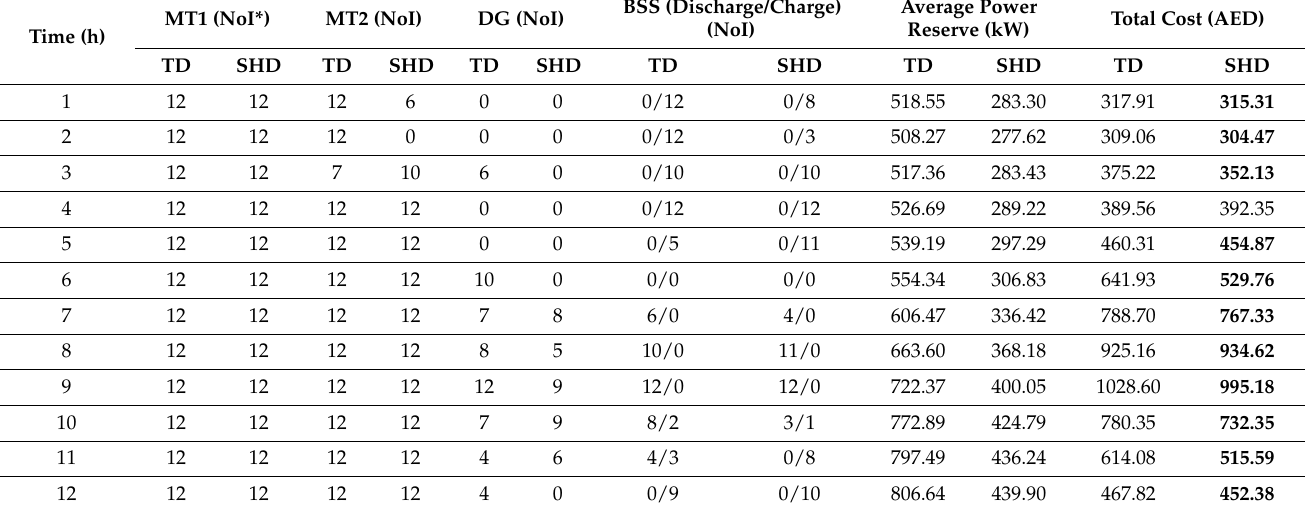
Table 5. Comparative data on traditional dispatch and proposed dispatch strategies on an hourly